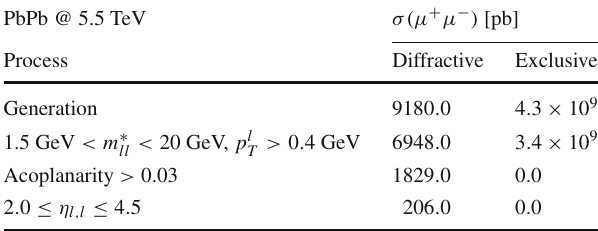
Table 2 Predictions for the dimuon production at forward rapidities in √ PbPb collisions at s = 5 . 5 TeV in exclusive and diffractive interac- tionsconsideringkinematicalcutsthatselectthe diffractive contribution